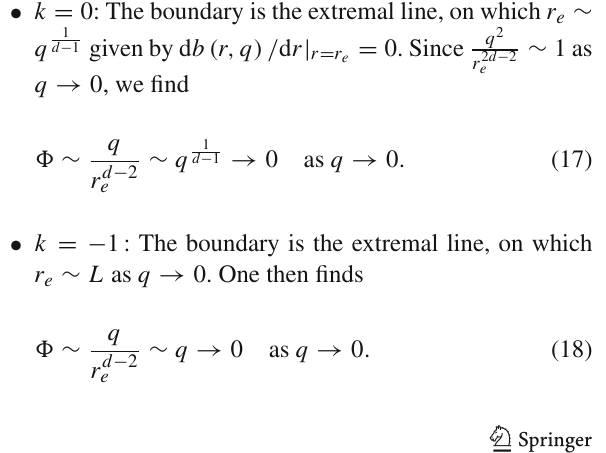
Fig. 2 The phase diagrams for Born–Infeld AdS black holes where L = 1 and β = 10. The blue lines are extremal black holes, while the red one is some regular spacetime with nonvanishing charges. Small figures are the plots of the potential along the boundary lines